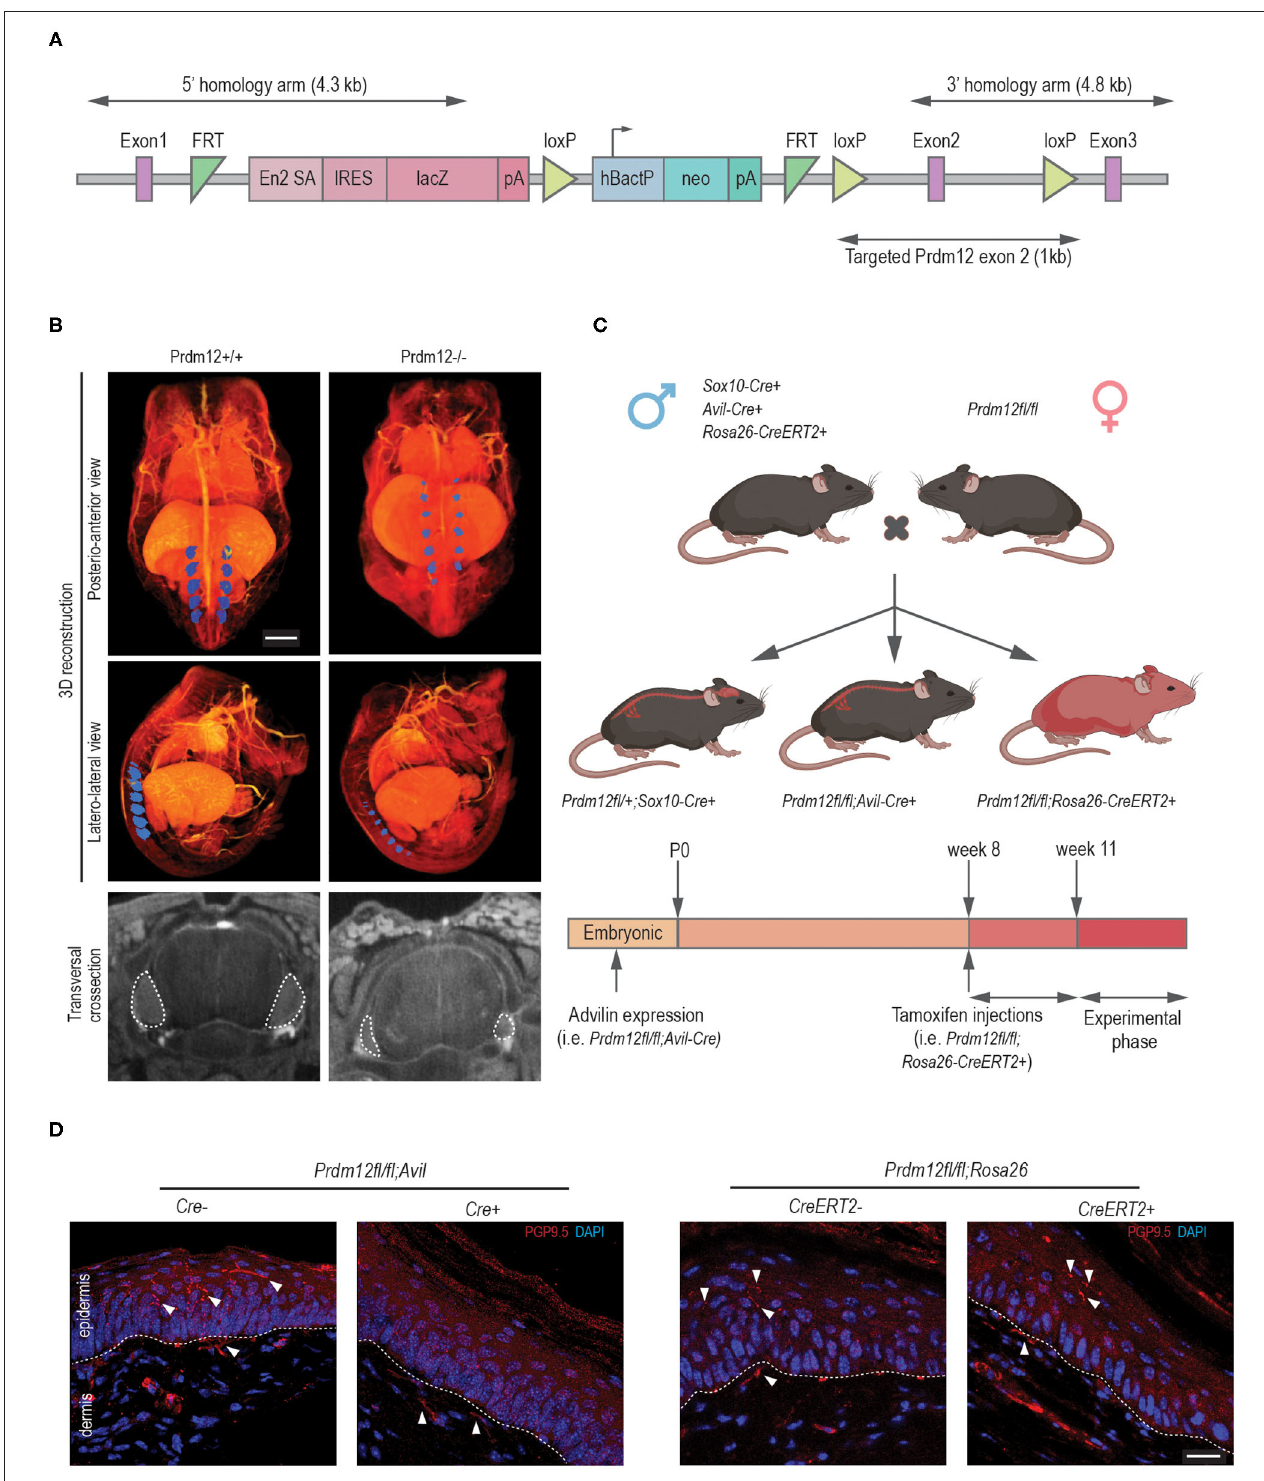
FIGURE 3 | Validation of animal models generated for the study. (A) A schematic representation of the lethal classical Prdm12 knock-out (KO) allele. (B) Lower panels, representative lumbar DRG cross-section micro-CT images of WT and Prdm12 − / − E15.5 embryos depicting a reduction of DRG volume in the Prdm12 − / − . Middle and upper panels—pseudocolored (blue) 3D reconstructed micro-CT images of lumbar DRG in WT and Prdm12 − / − 15.5 embryos, as indicated—posteroanterior (upper panels) and latero-lateral view (middle panels). Scale bar is 1,000 µ m. Transversal cross-section of the SC with DRG outlined with a white dotted line (bottom panel). (C) Schematic of the genetic crosses performed to generate developmental constitutive Prdm12 fl / fl ; Avil-Cre and Prdm12 fl / fl ;